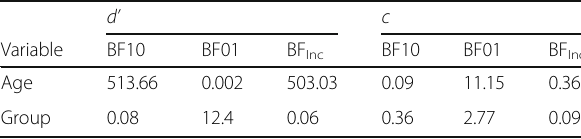
Table 1 Bayes Factors (BFs) for each predictor variable on d ’ (sensitivity) and c (bias) d ’